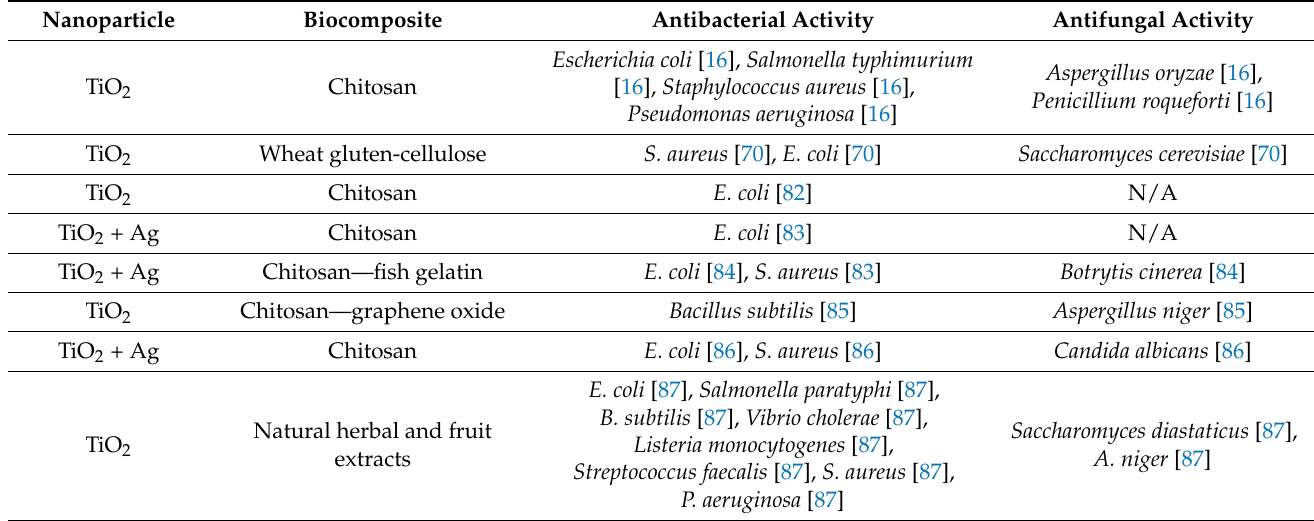
Table 1. Composition of different active food packagings and their antimicrobial